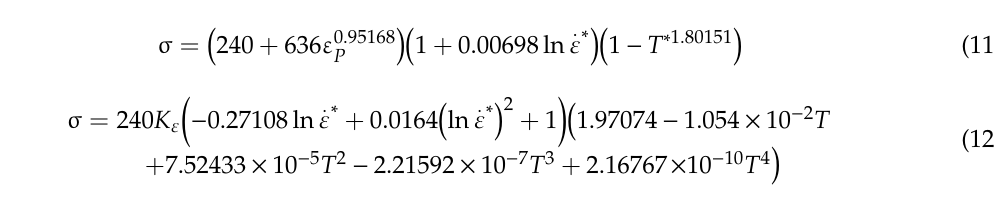
Figure 6. ( a ) The relation between ln ( T ∗ ) and ln ( 1 − σ / ( A + B ε P at 2000 s ‒ 1 . ( b ) The relation between (cid:1837) (cid:3021) and T at 2000 s ‒ 1 .